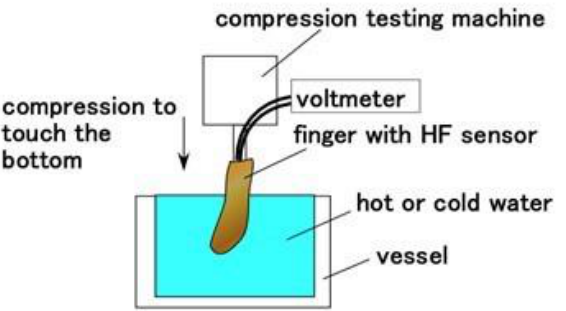
Figure 14. Schematic diagram of the experimental apparatus of touching thermal water and bottom of a vessel.